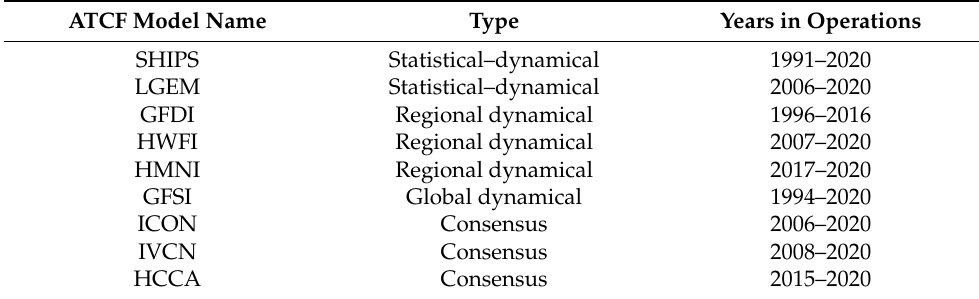
Table 2. NHC’s deterministic intensity guidance.